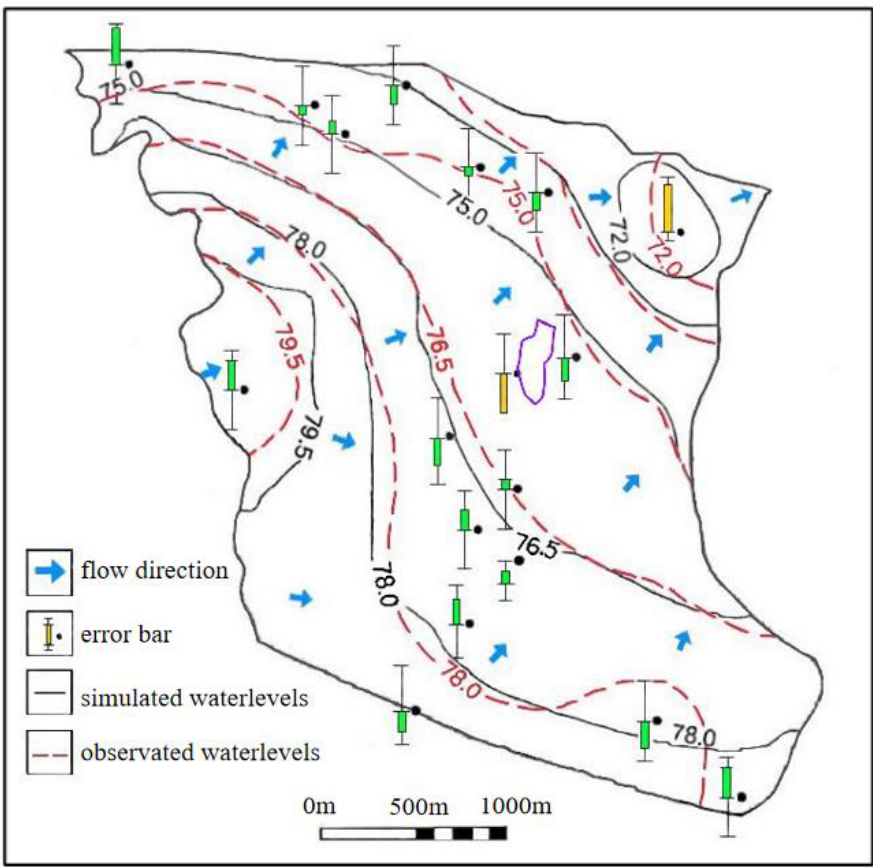
Figure 6. Fitting result of simulated and actual groundwater flow field.